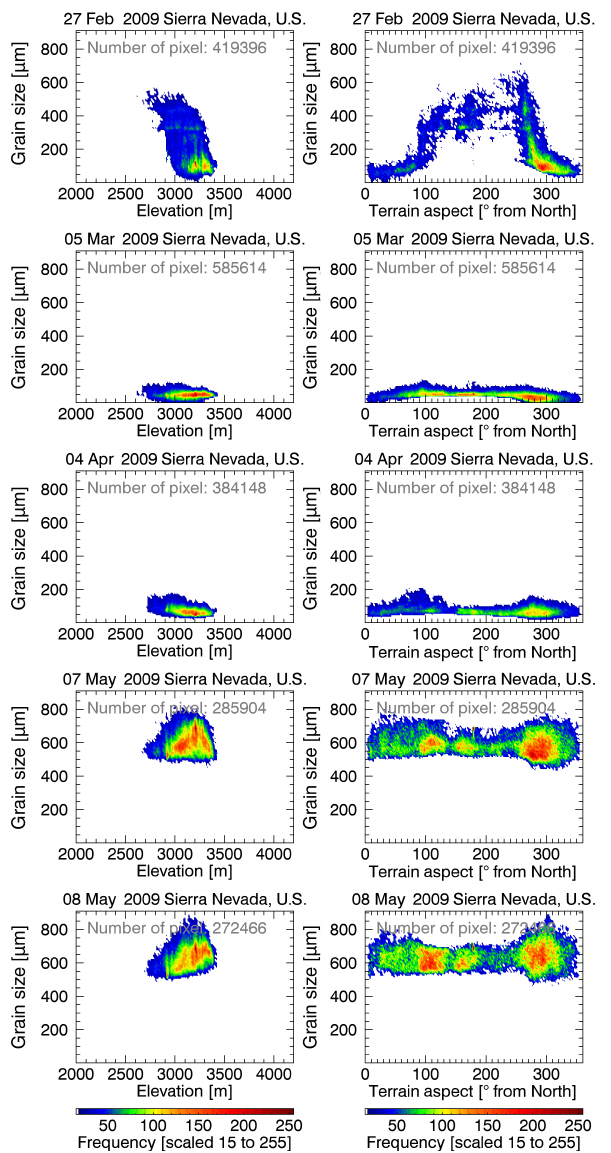
Figure 9. Same as Fig. 8 but for the Rocky Mountains in spring 2011. Note: a rare retrieval artifact is found on 15 June where Eq. (4) has no unique solution within a snow grain size range of 540 to 570 µm, causing a gap in the corresponding